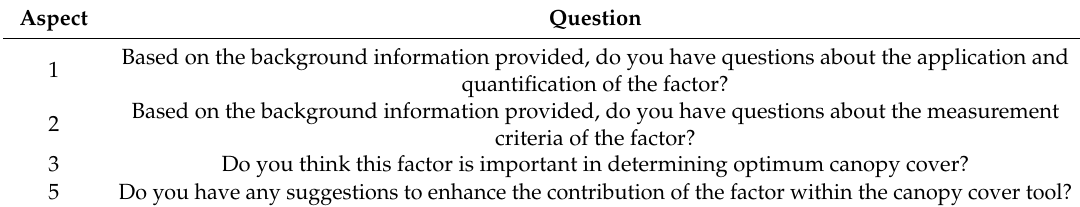
Table 2. Questions considered by focus group for each factor and measurement criteria utilized by the